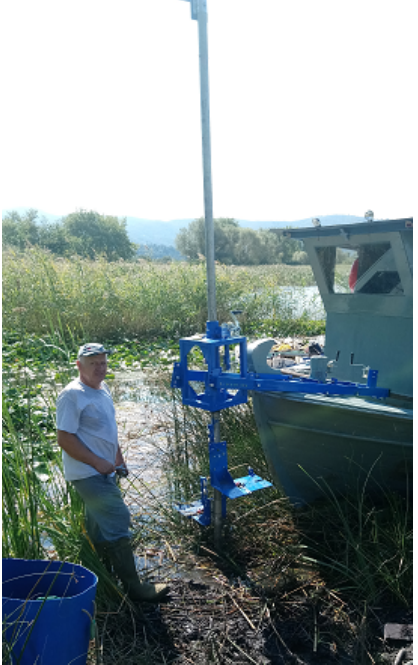
Figure 6. Supporting infrastructure for the acquisition of GPS and hydroacoustic